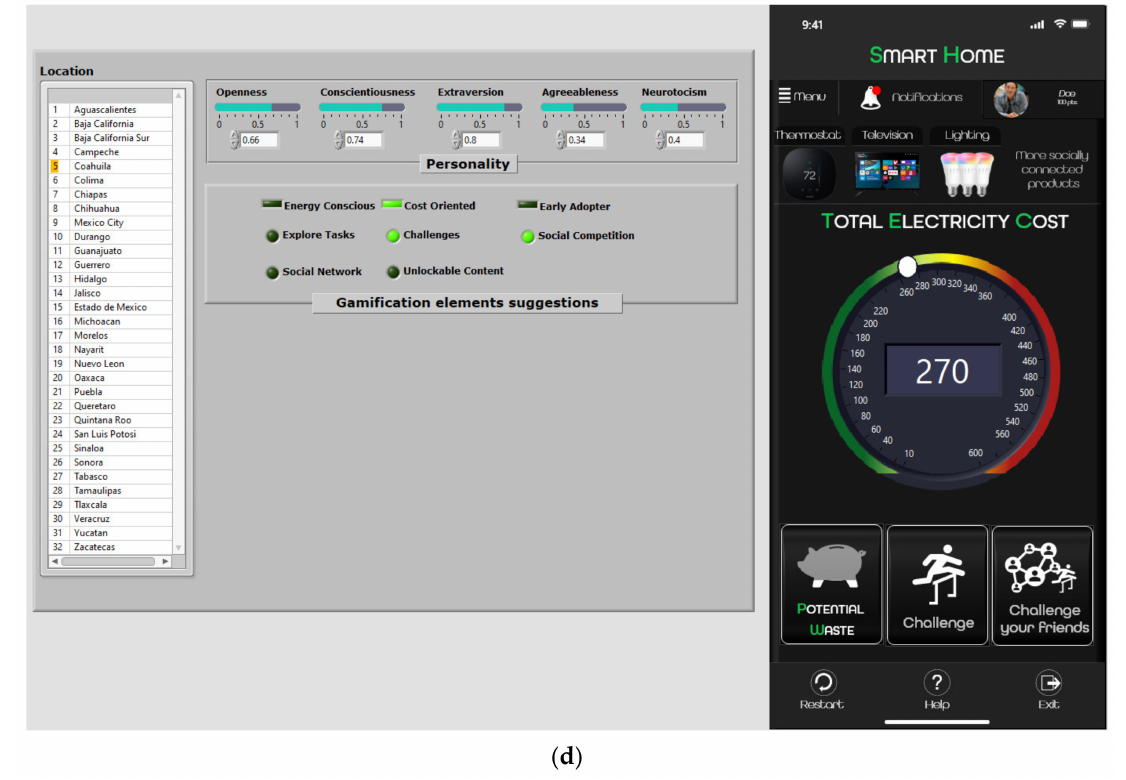
Figure 11. Tailored gamified interfaces for different locations and personalities: ( a ) Campeche interface, ( b ) Queretaro interface, ( c ) Estado de Mexico interface, and ( d ) Coahuila